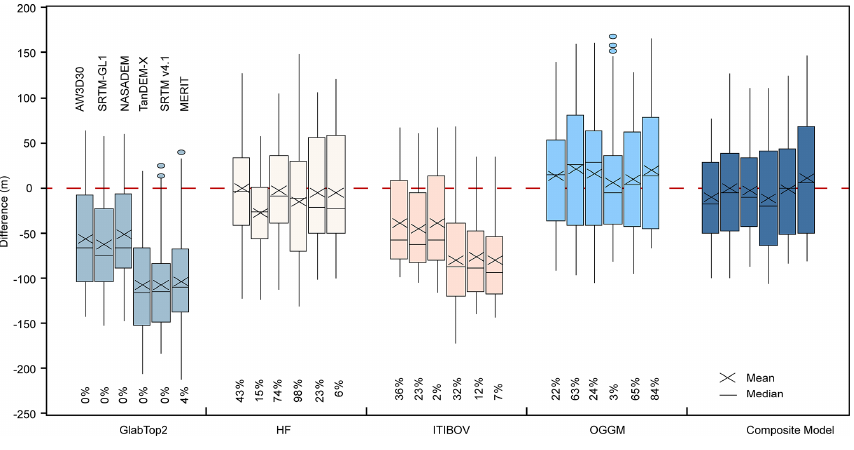
Figure 9. Point-by-point deviation comparison between the modeled and measured ice thickness from GlabTop2, HF, ITIBOV, OGGM, and the composite result. In each group, the boxes are plotted in the following order: AW3D30, SRTM-GL1, NASADEM, TanDEM-X, SRTM v4.1, and MERIT. Different models using the same DEM are aggregated by weights (labeled at the bottom) to achieve minimum mean absolute error.